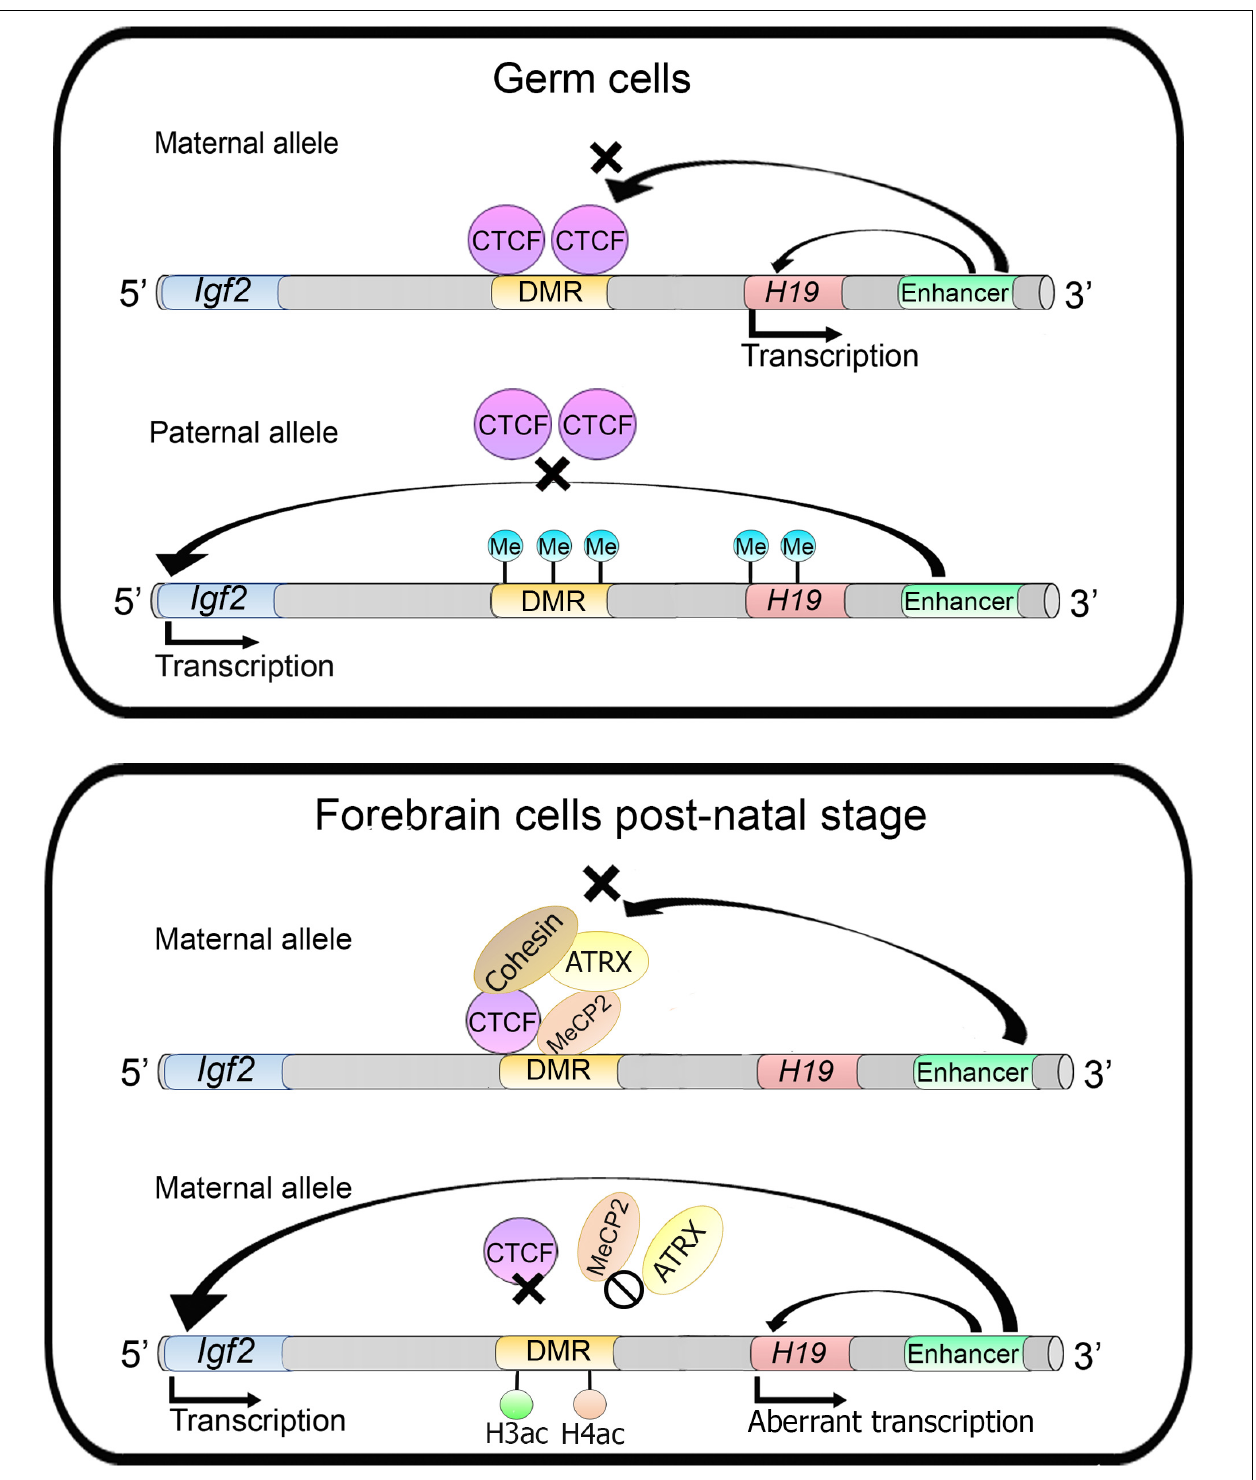
FIGURE 7 | ATRX activity regulates imprinted genes. In germ cells into the Igf2 / H19 locus, Igf2 gene is silenced through insulator establishment by CTCF and only the H19 gene is expressed in maternal alleles. Whereas in the paternal allele the DMR is methylated preventing CTCF binding and impairing insulator activity allowing Igf2 transcription. On the other hand, in forebrain cells of postnatal mice, in the maternal allele, the H19 gene is silenced. MECP2 directs ATRX and cohesin recruitment to the DMR. MECP2 or ATRX depletion increases histones H3 and H4 acetylation which lead to changes in nucleosome occupancy and CTCF binding, causing an aberrant transcription of the H19